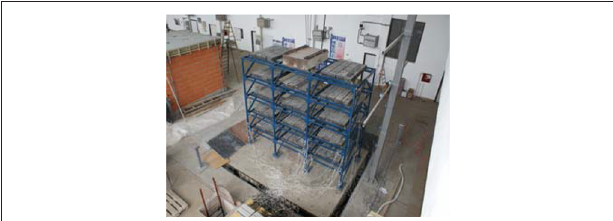
FIGURE 1 | Tested structure without dampers—MODEL01.